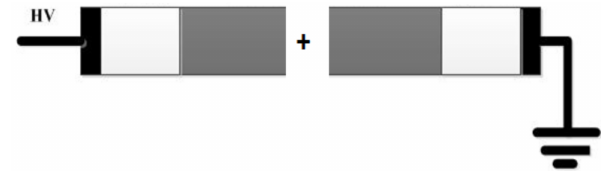
Figure 10. Two single arc model.